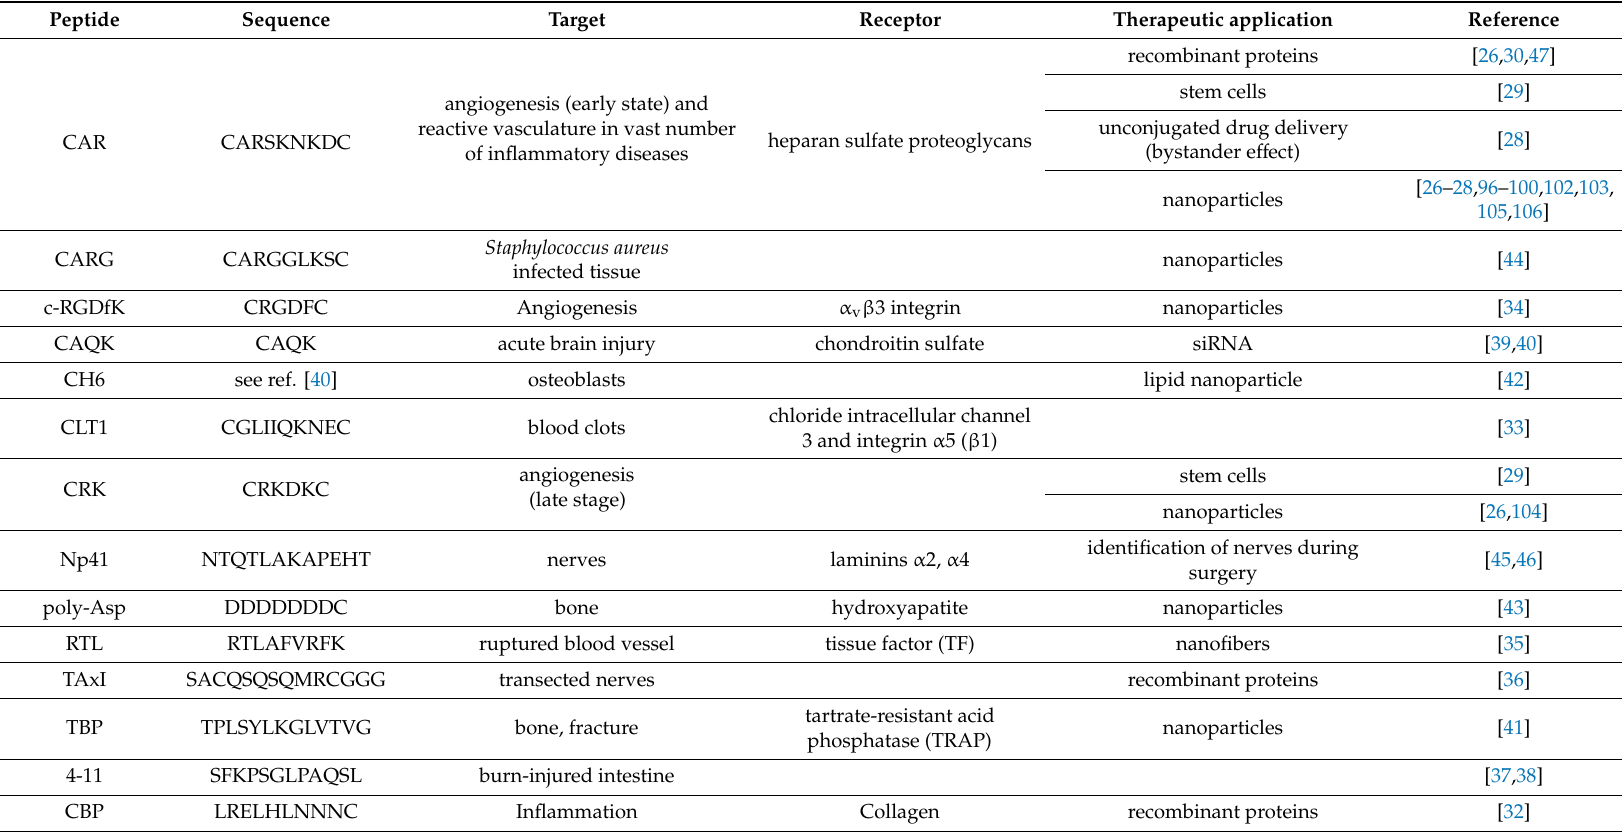
Table 1. Vascular homing peptides described for regenerative purposes in tissue